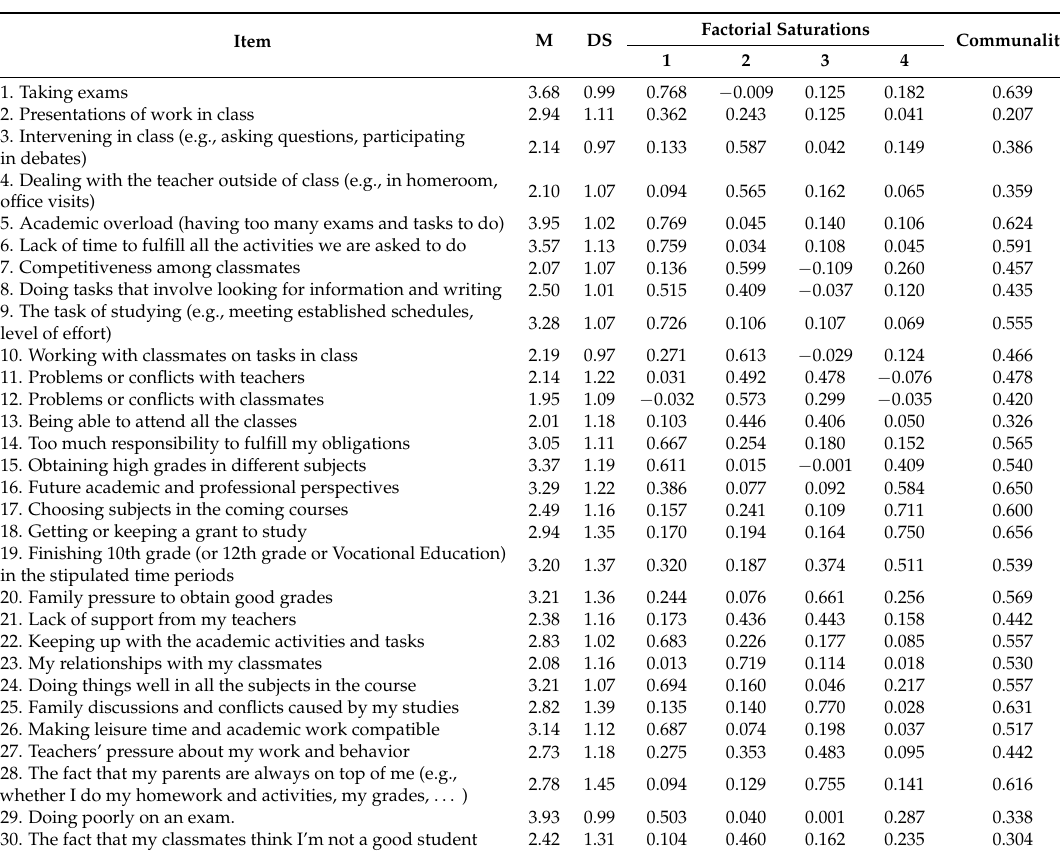
Table 2. Means, standard deviations, factor loadings and communalities in the initial 30-items version of the Questionnaire on Academic Stress in Secondary Education